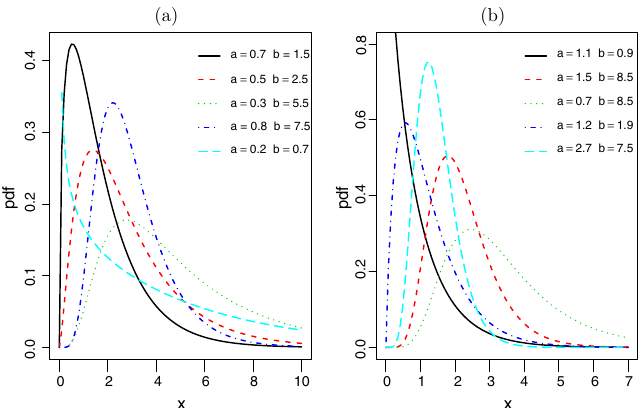
Fig. 1 Some pdfs of the KB